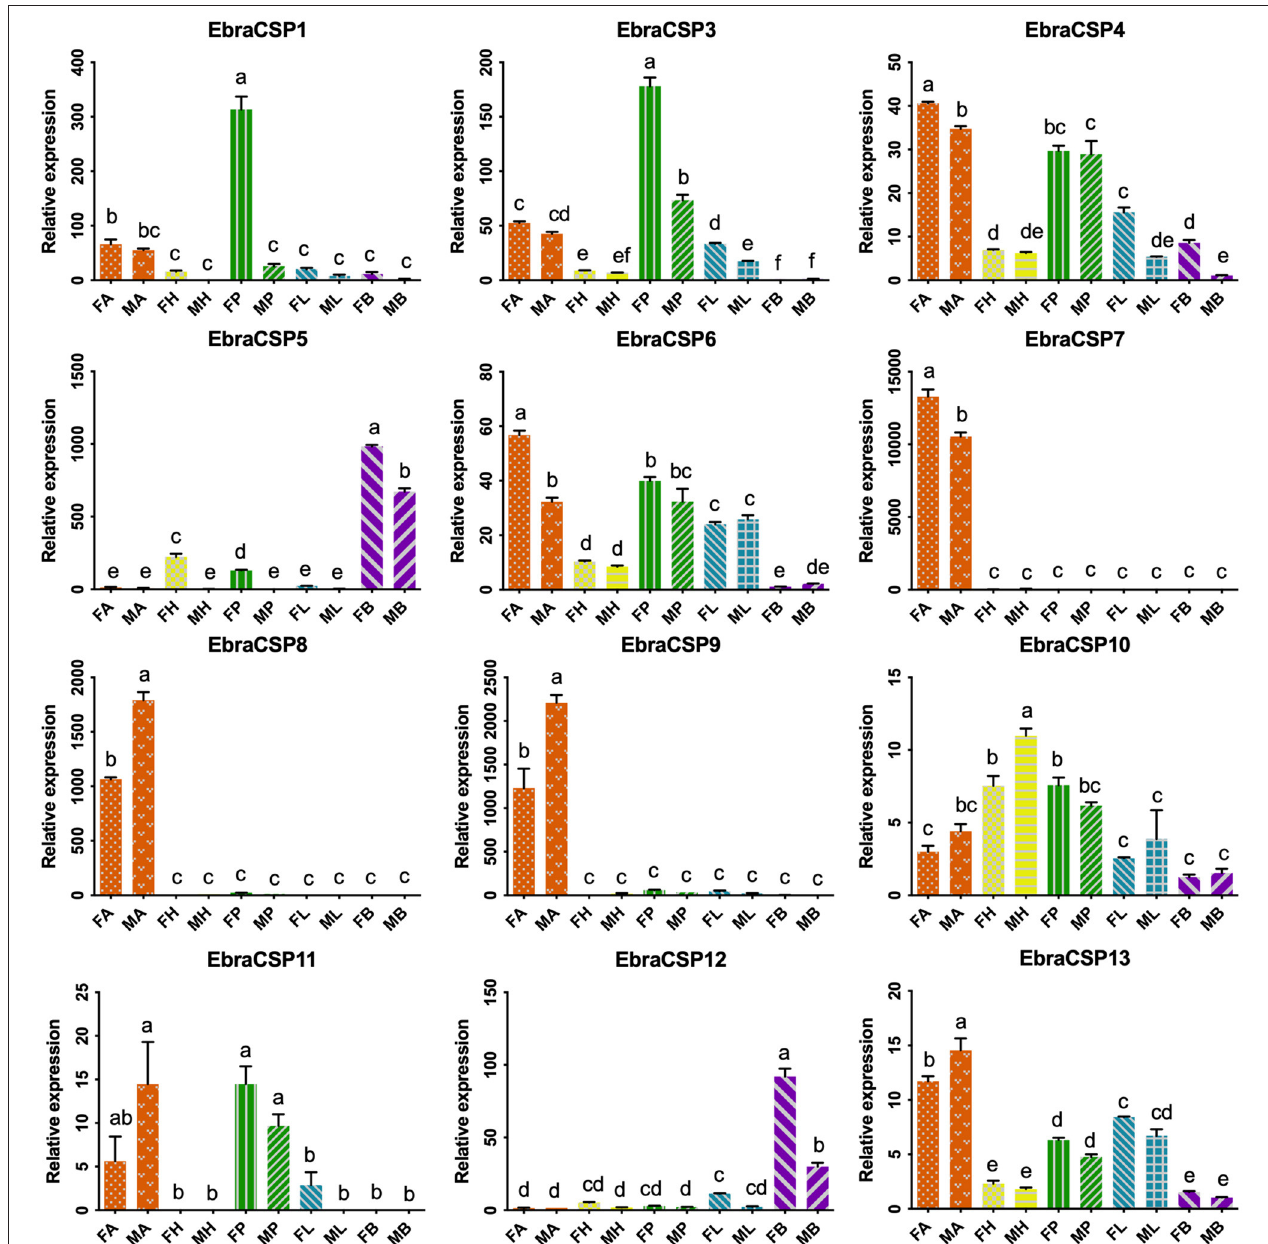
FIGURE 3 | Relative expression levels of EbraCSPs in different tissues of adults. FA, female antennae; MA, male antennae; FH, female head (without antennae); MH, male head (without antennae); FP, female proboscises; MP, male proboscises; FL, female legs; ML, male legs; FB, female abdomen; MB, male abdomen. The bar represents the standard error, and the different small letters (a–f) above each bar indicate significant differences ( P < 0.05).